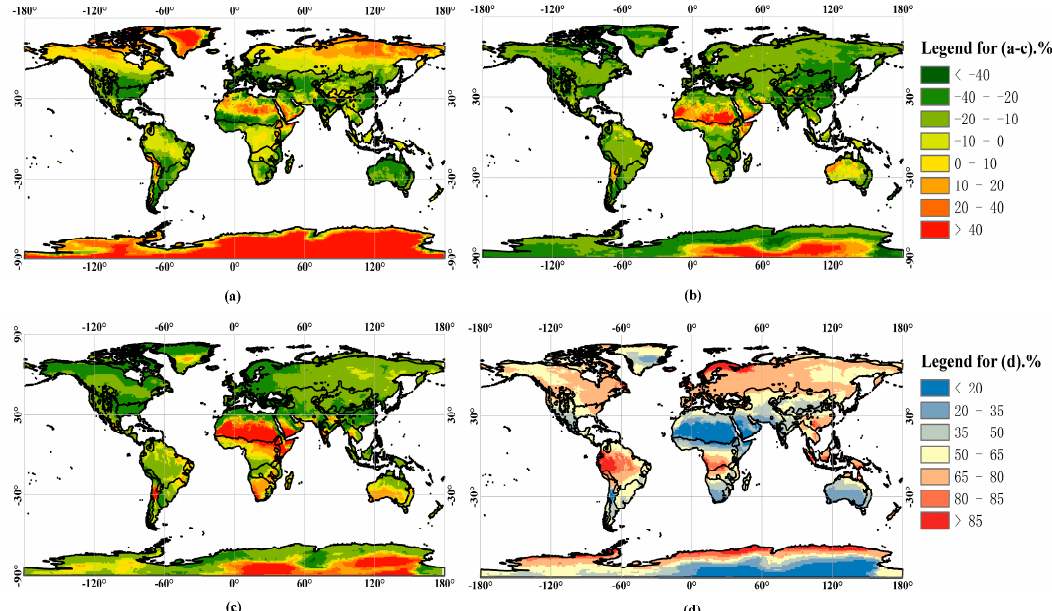
Figure 5. Annual MODIS cloud cover and ARE between the reanalyzed cloud cover and the MODIS cloud cover averaged from 2001 to 2009: ( a ) ARE of ERA-Interim; ( b ) ARE of JRA-55; ( c ) ARE of NCEP-DOE; ( d ) MODIS annual cloud cover. Table 5. Specify that ARE of the cloud cover is obtained by comparison of reanalysis with MODIS (MOD08) data (ARE unit: %; SR: solar radiation, CC: cloud cover). Climatic Zones